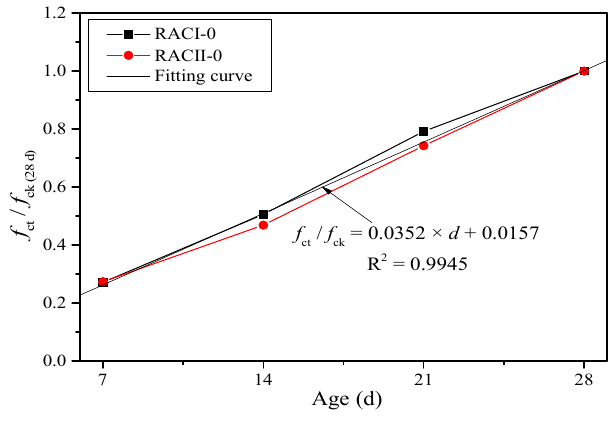
Figure 12. Unified fitting curve of coefficient α.